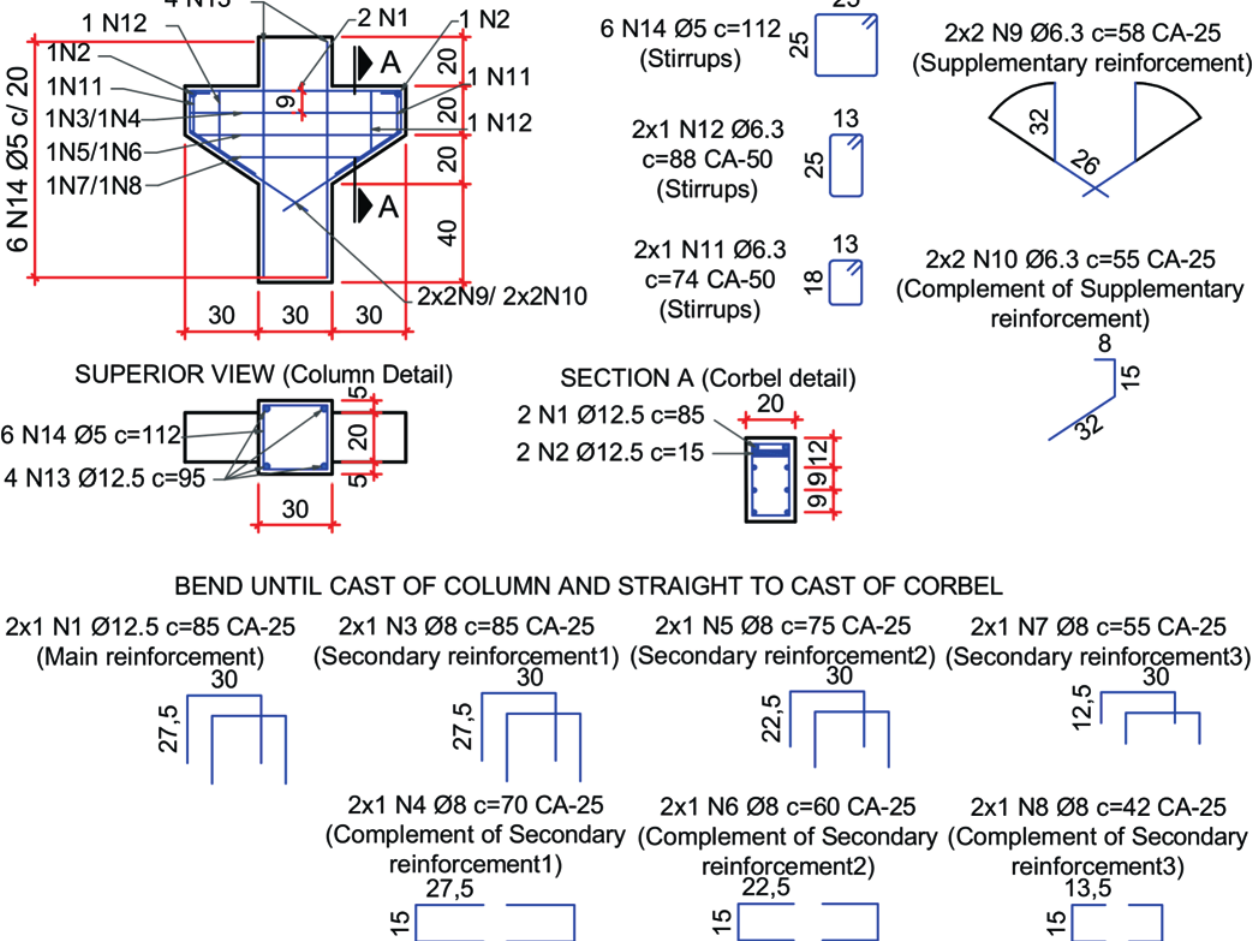
Reinforcement detail of model with corbel cast in different stage from the column (P3) with bent main